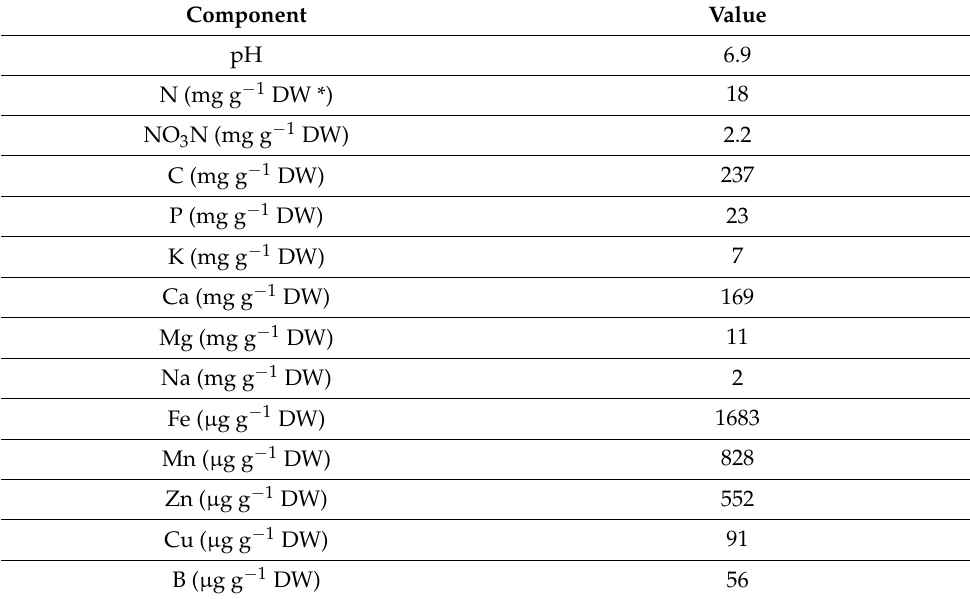
Table 4. Chemical composition of vermicompost tea